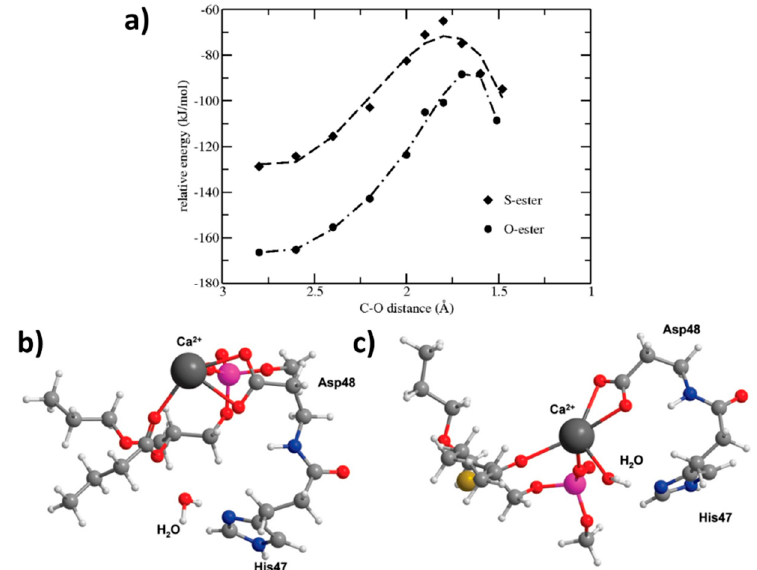
Figure 6. Energies for the O ‐ ester and S ‐ ester substrates calculated with different, fixed distances between the oxygen from water and the carbonyl carbon. Conformations of these minimized ester substrates are considerably different; (b) O ‐ ester with the associated water molecule close to the carbonyl group; (c) the S ‐ ester prefers a different location in the active site with a large distance between the water molecule and the carbonyl group. Ca 2+ (dark gray), P (pink), O (red), N (blue), S (yellow), C (light gray) and H (white). Reproduced with permission from [44].